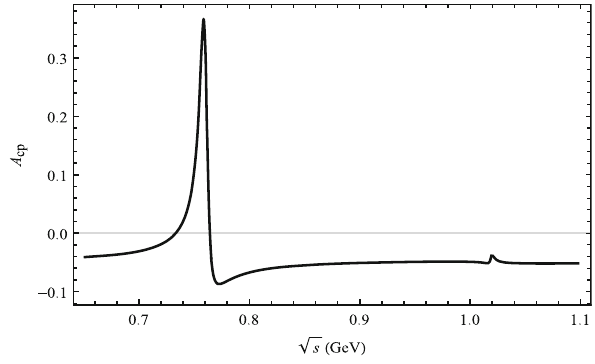
Fig. 2 Plot of A CP as a function of parameter values of CKM matrix elements for the decay channel of ¯ B 0